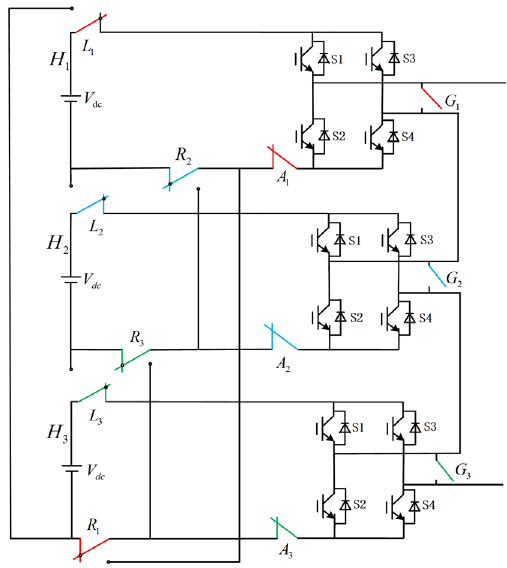
Figure 4. Proposed serial fault-tolerant topology.